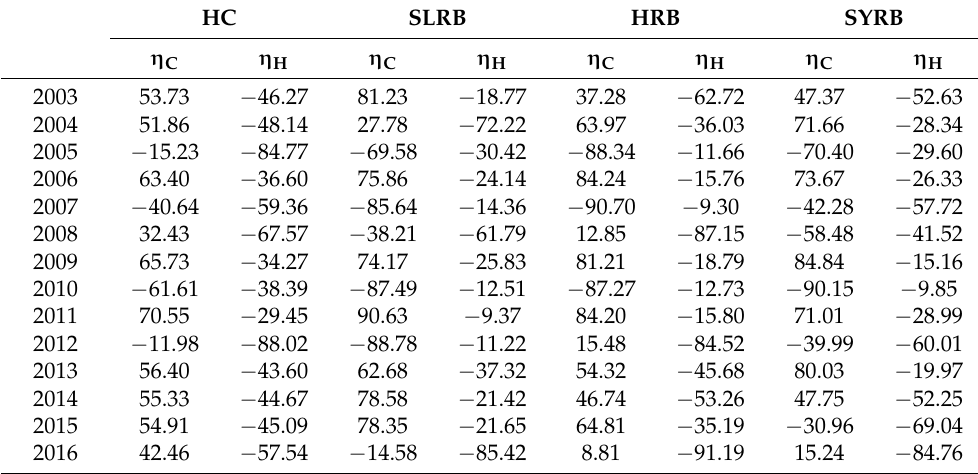
Table 4. Contributions (%) of climate factors and human factors to GWS changes in the HC and its three subregions.